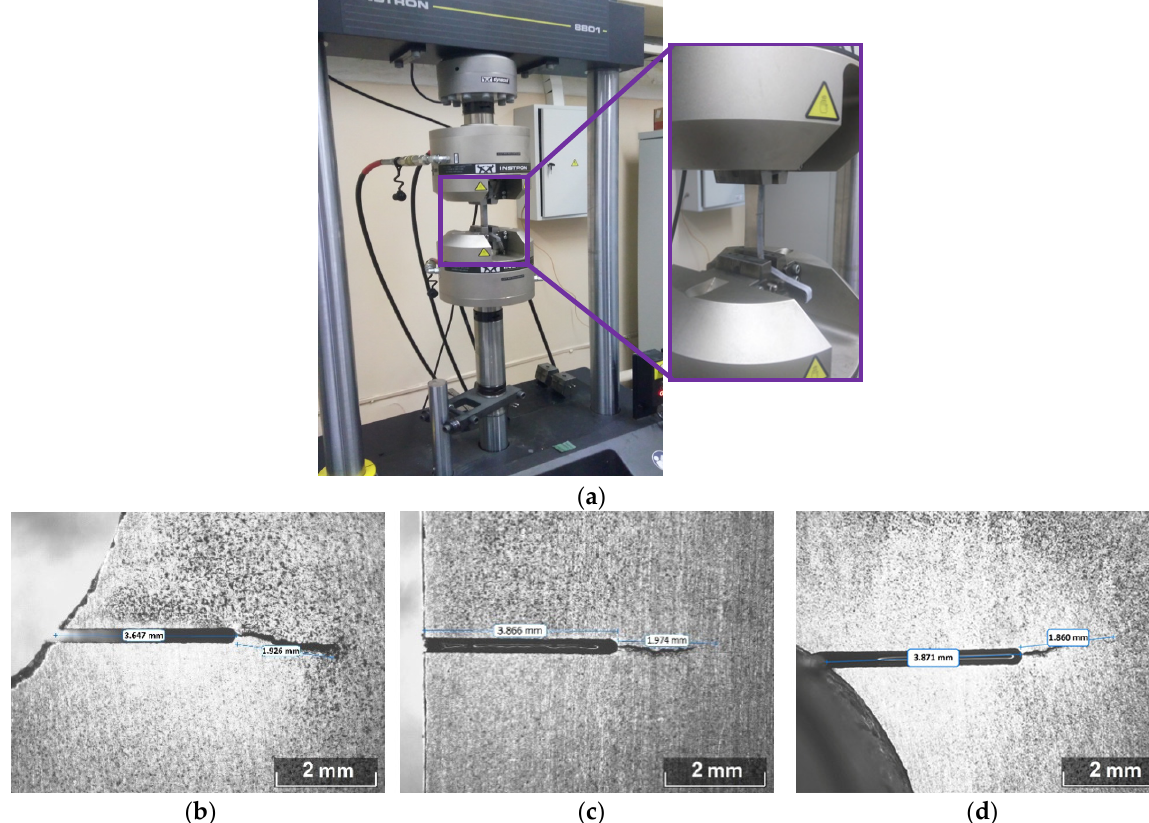
Figure 2. Sample installed in the testing machine ( a ) and images of the cracks grown in the foot ( b ), web ( c ) and head ( d ) of the sample .